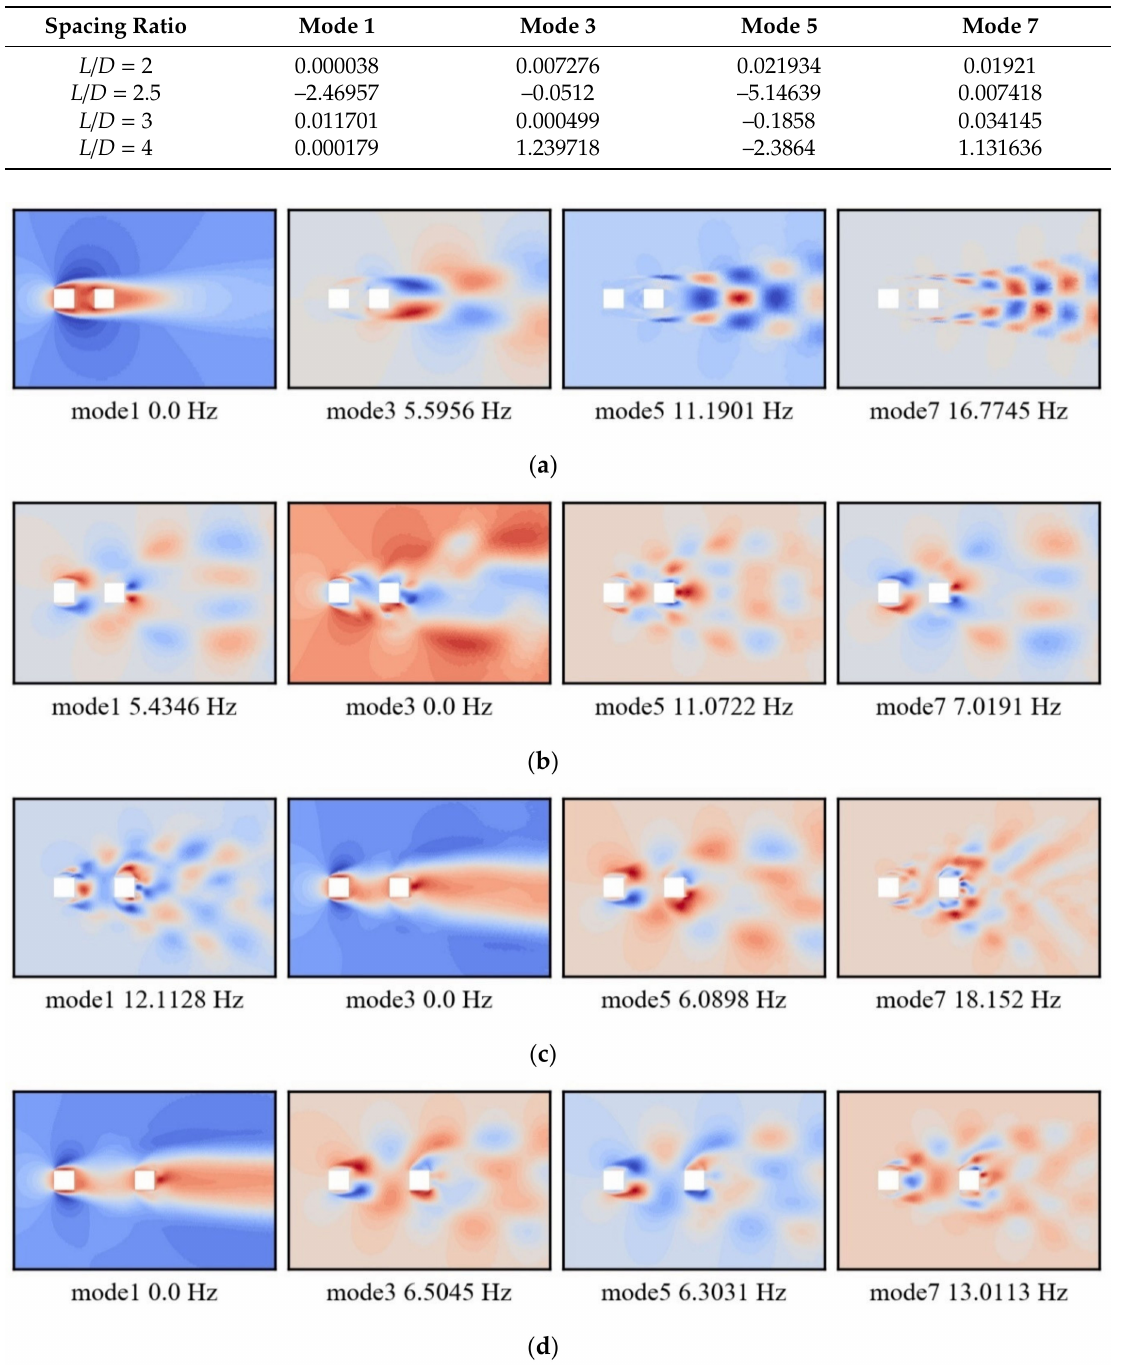
Table 4. Growth rate (decay rate) of the DMD modes at di ff erent spacing ratios.